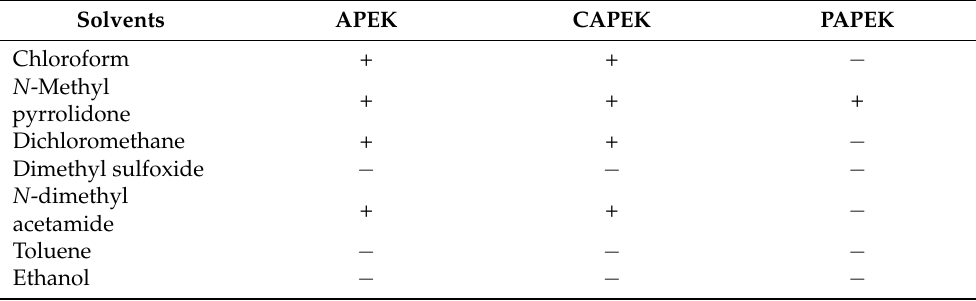
Figure 1. ( a ) 1 H NMR of APEK and CAPEK; ( b ) FT-IR spectra of CAPEK, PAPEK-virgin, and PAPEK-130 membranes. Table 1. Solubility of APEK, CAPEK polymer and PAPEK-virgin membrane in some solvents (Ca. 0.1 g in 2 mL of various solvents at room temperature for 24